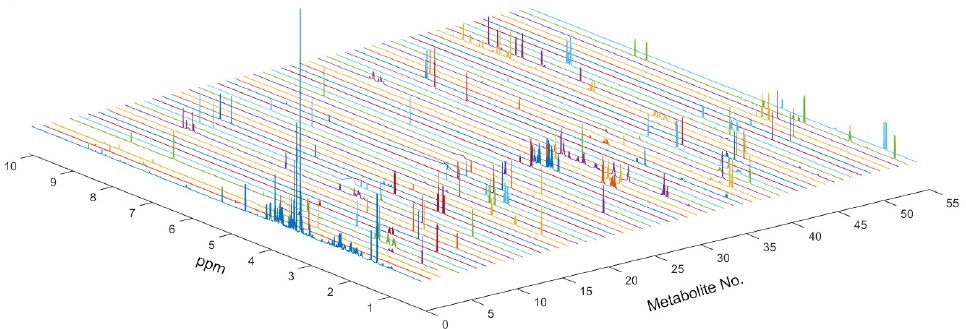
Figure 1. NMR spectrum of metabolites used on AQuA of the global spectrum. Fifty-eight metabolites used in this AQuA were confirmed by using HMDB and BMRB data.